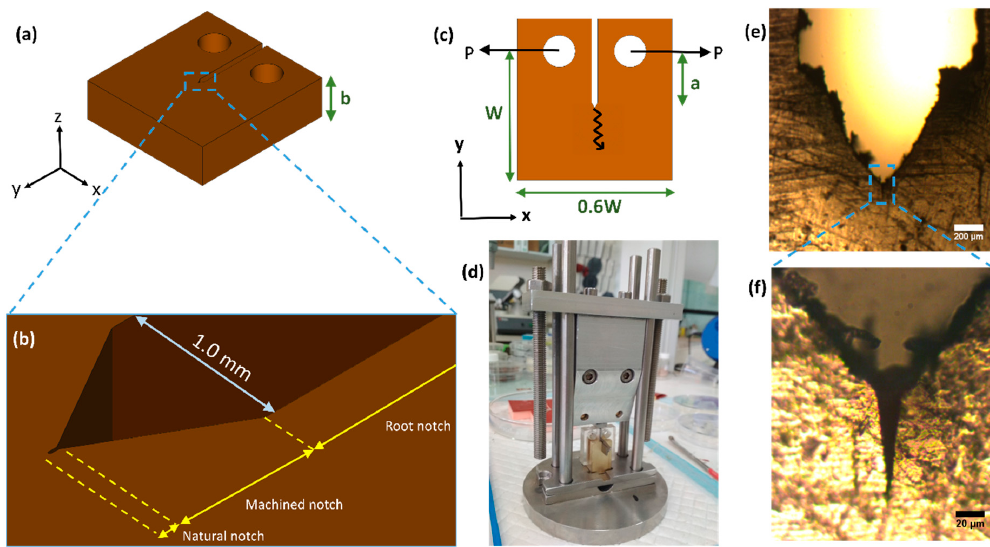
Figure 3. Specifications of compact-tension specimens according to ASTM D5045-99. ( a ) A three-dimensional view where b is the specimen thickness along the Z -axis. ( b ) Zoomed-in illustration of the specimen notch. ( c ) A two-dimensional view of the XY -plane elucidating the specimen characteristic length W, the initial crack length a and the directions of the load (P) and crack propagation (zigzag arrow) during a test. ( d ) A photograph of the Guillotine used to generate the natural notch. ( e ) Light-microscopy image of the V-shaped notch created by a rotating disc. ( f ) Zoomed image of the natural notch created by the